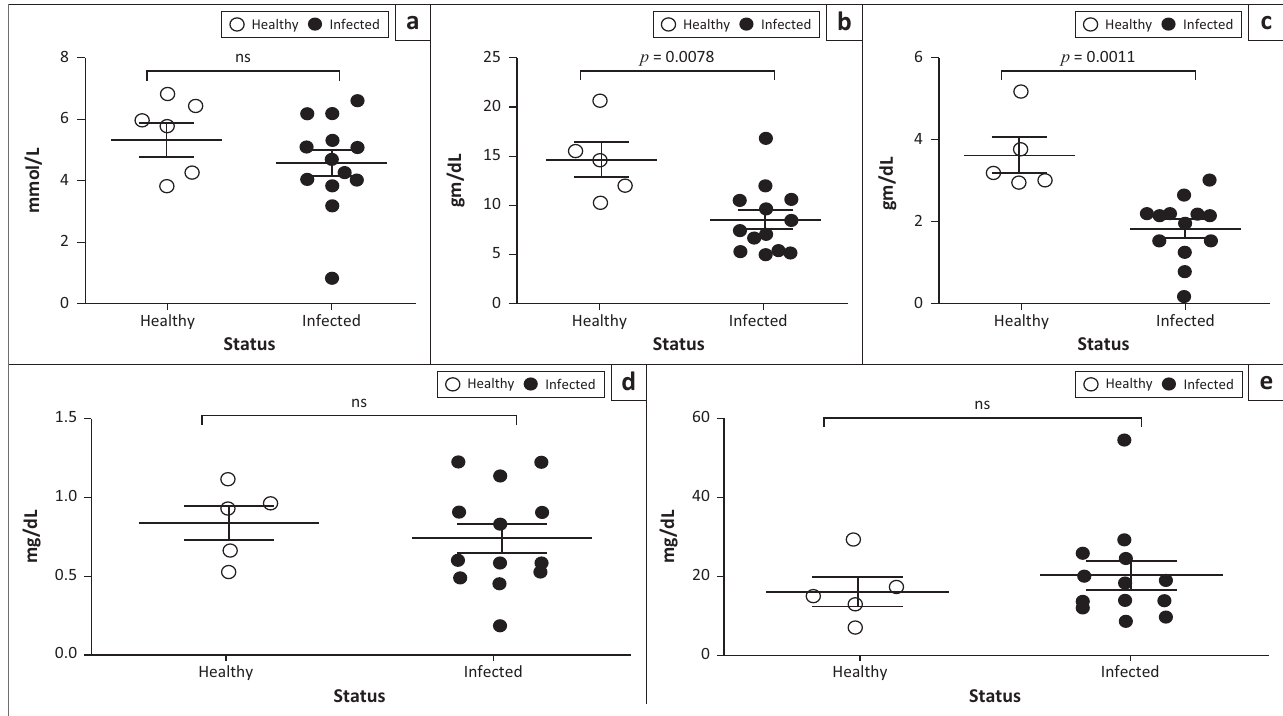
FIGURE 4: Peste des petits ruminants virus–infected Black Bengal goats showed altered serum biochemical profiles. Serum samples were collected from healthy and peste des petits ruminants –affected goats and the level of (a) glucose, (b) total protein, (c) albumin, (d) bilirubin and (e) blood urea nitrogen was quantified. Data indicate mean ± SEM from 5 healthy and 13 peste des petits ruminants virus–infected goats. One-tailed Mann–Whitney test. p ≤ 0.05 was considered statistically significant.